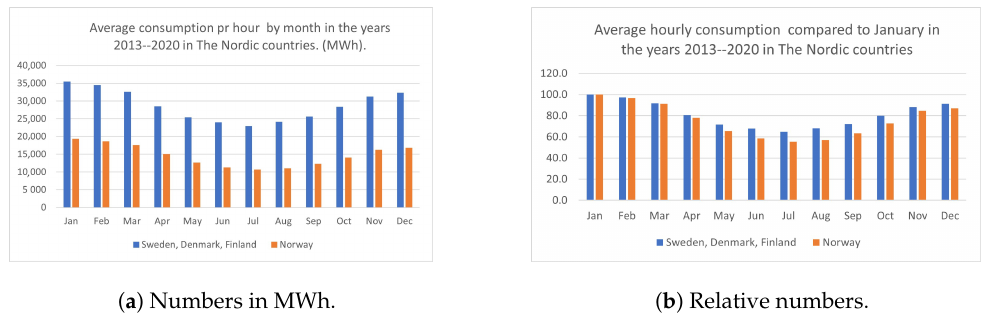
Figure 1. The average consumption per hour in the different months in all Nordic countries measured in MWh ( a ) and measured as the percentage of consumption in January ( b